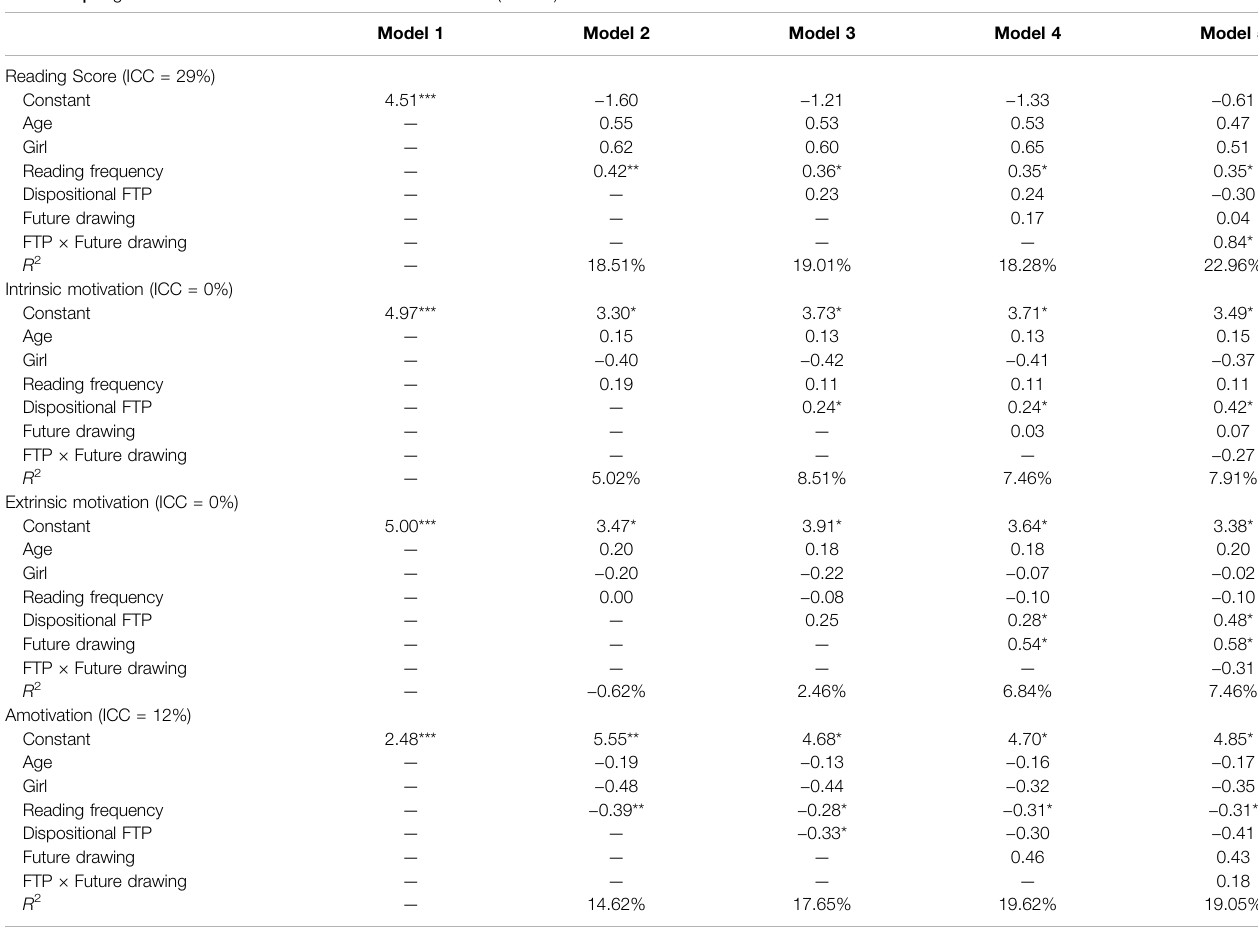
TABLE 2 | Regression coef fi cients of the multilevel linear models (N (cid:1)